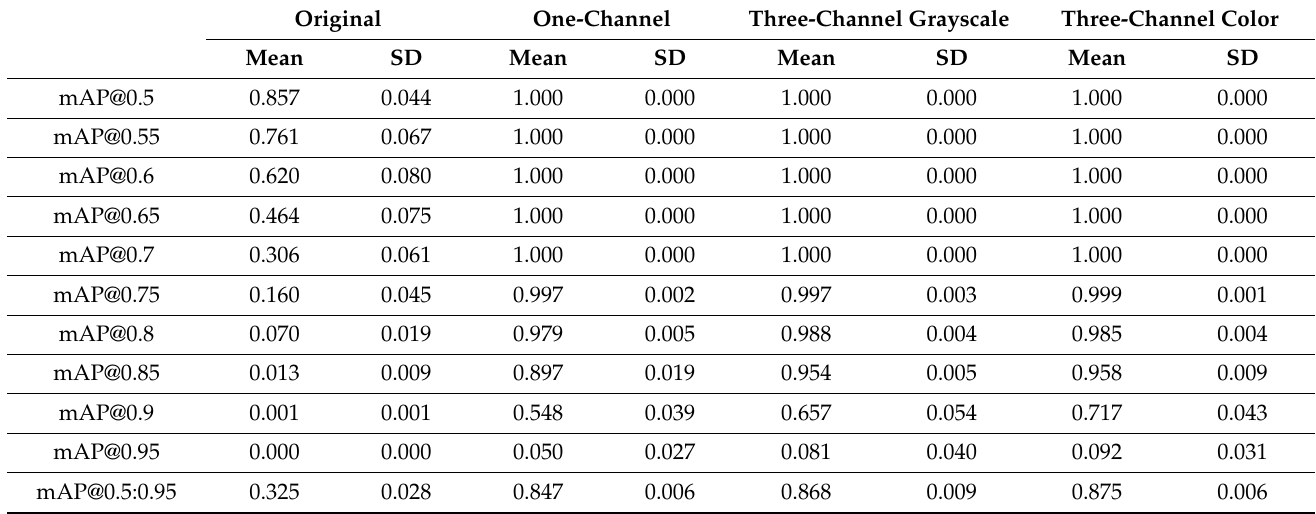
Table 12. YOLOv4-tiny object detection validation results with the augmented dataset.